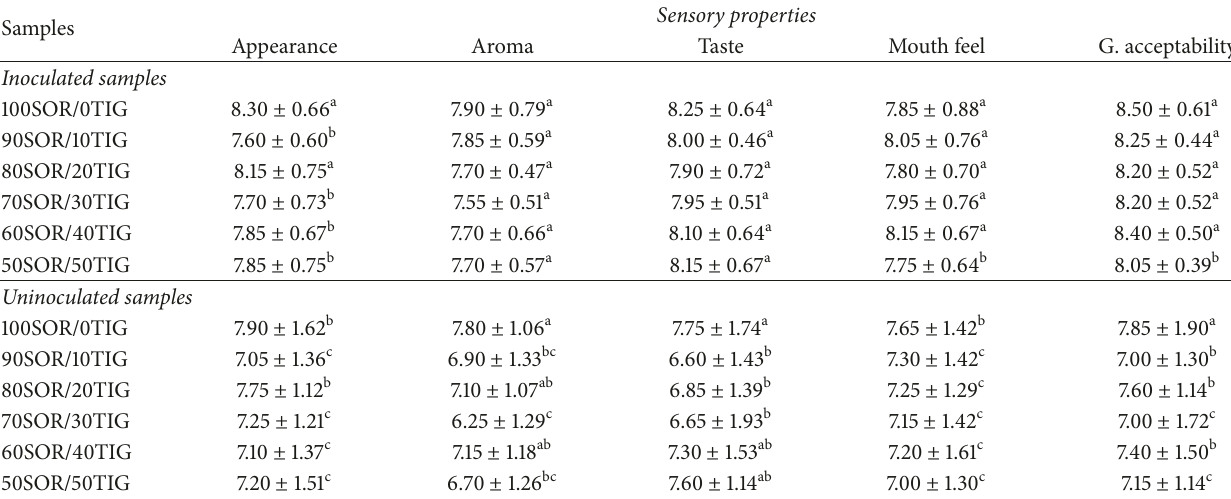
Table 4: Mean sensory scores of starter culture inoculated and uninoculated kunnu-aya